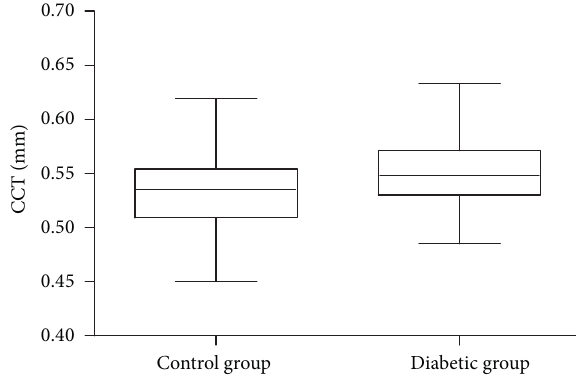
Figure 2: CCT values in patients with diabetes and in the control